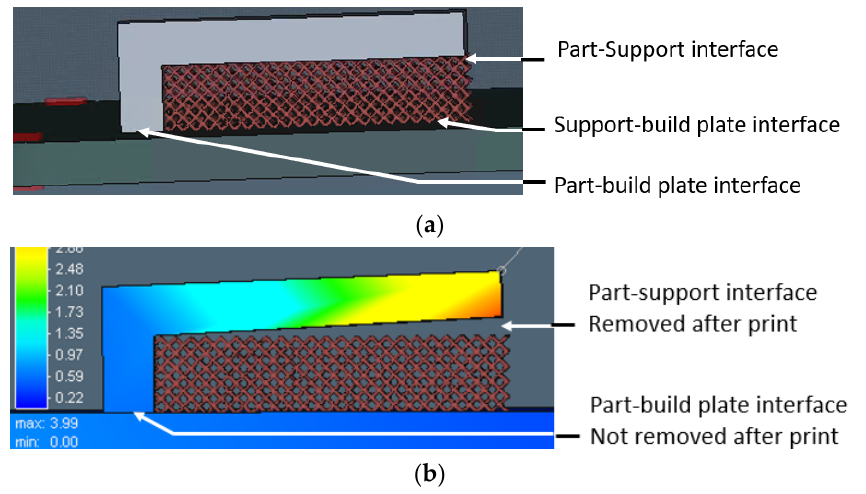
Figure 5. FEA details to simulate experimental steps of support removal. ( a ) Boundary condition in FE model. ( b ) FE simulation result after support removal.